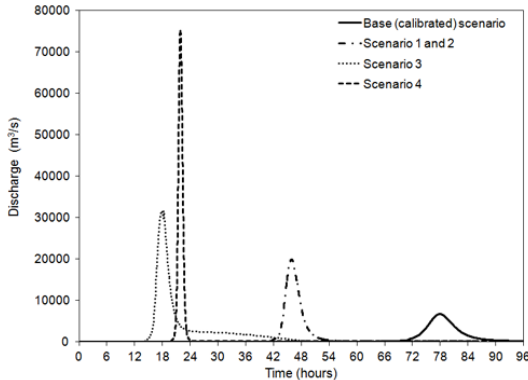
Fig. 11. Output hydrographs of the BREACH